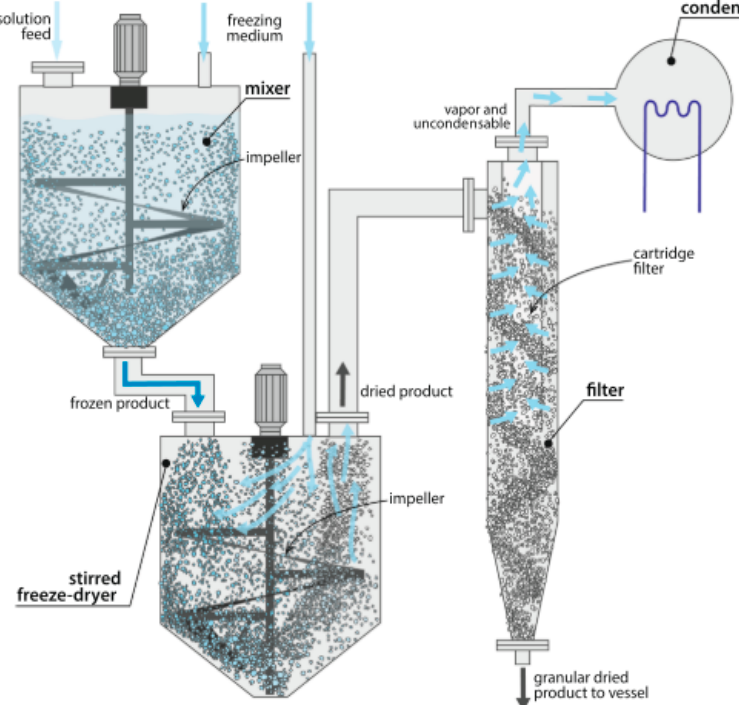
Figure 6. Schematic design of the stirred freeze-drying process. Reprinted with permission from Pisano et al., Eur. J. Pharm. Biopharm. 2019 , 142, 265–279. Copyright (2019) Elsevier. [97].